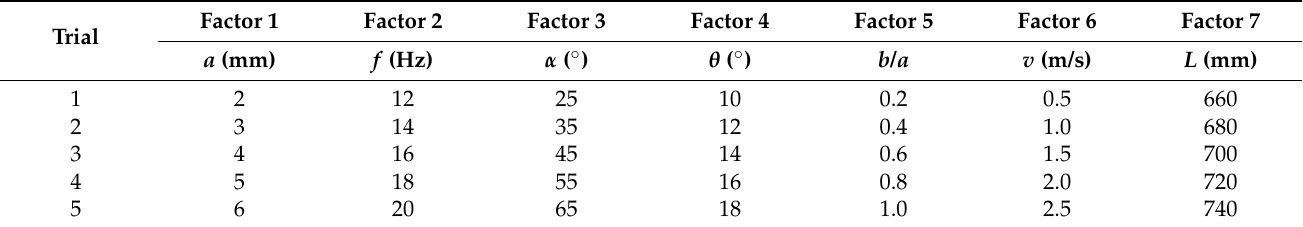
Table 5. Factors and levels in the orthogonal experiment.